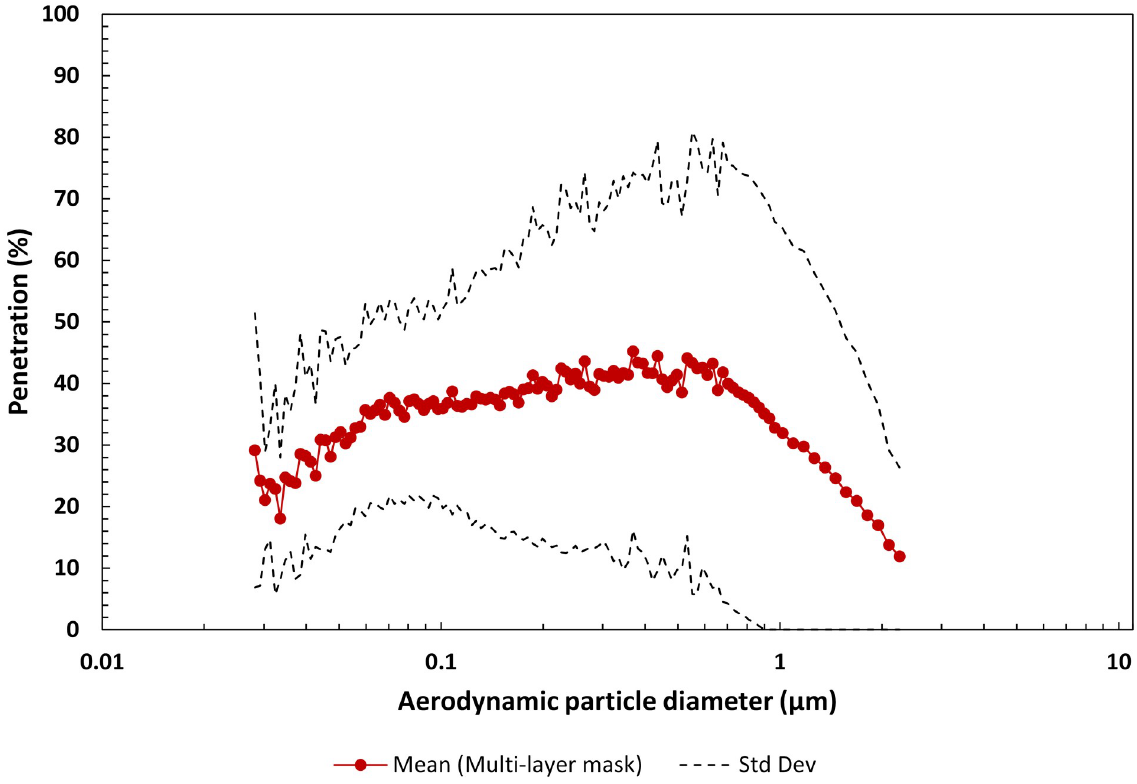
Fig 5. Mean penetration profile as a function of aerodynamic particle diameter for the material of seven fabric masks with an internal layer to augment filtration. Note, the penetration range is 0 to 100%. Multi-layer material systems included: i) cotton/electret furnace filter/ cotton, ii) cotton/procedure mask/cotton, iii) cotton/electret filter membrane/cotton, iv) cotton/quilt batting/cotton, v) cotton/polypropylene shopping bag/cotton, vi) cotton/polypropylene craft 1/cotton, and vii) cotton/polypropylene craft